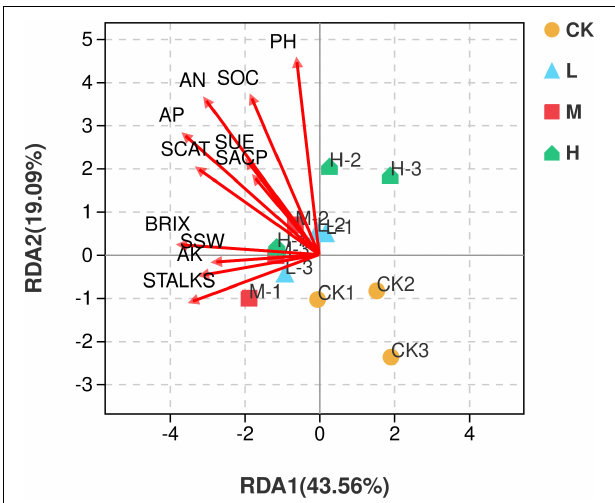
FIGURE 9 | Distance-based Redundancy analysis of different treatments and environmental factors including soil properties and yield parameters. Red arrows represent environmental factors, and the arrow length represents the degree of influence on different